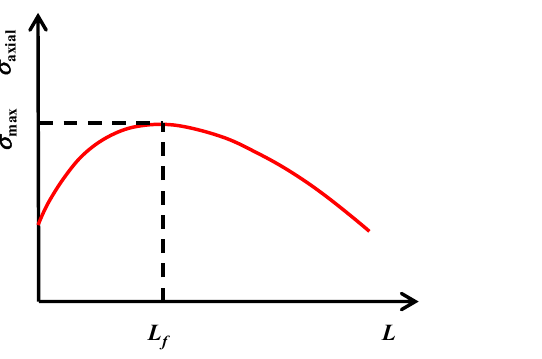
Figure 14. Diagram of the axial stress σ axial as a function of the wing crack length L.